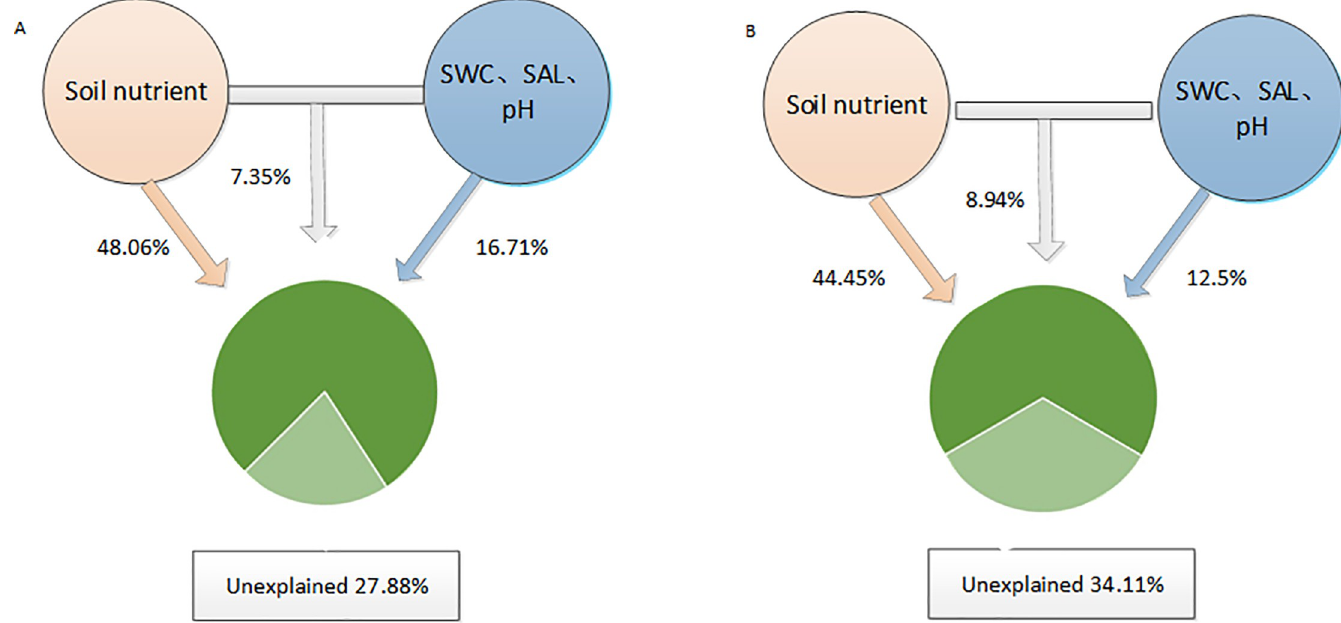
Fig 8. The variance partitioning analysis (VPA) for the soil microbial community with soil nutrients and soil water content (SWC), soil salinity (SAL) and pH: (A), bacterial community; (B), fungal community.